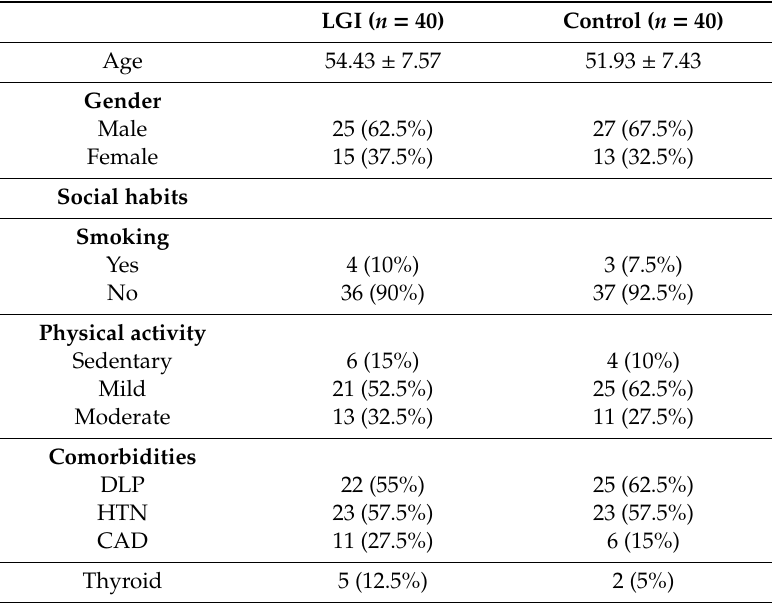
Table 2. Demographics of the study participants.